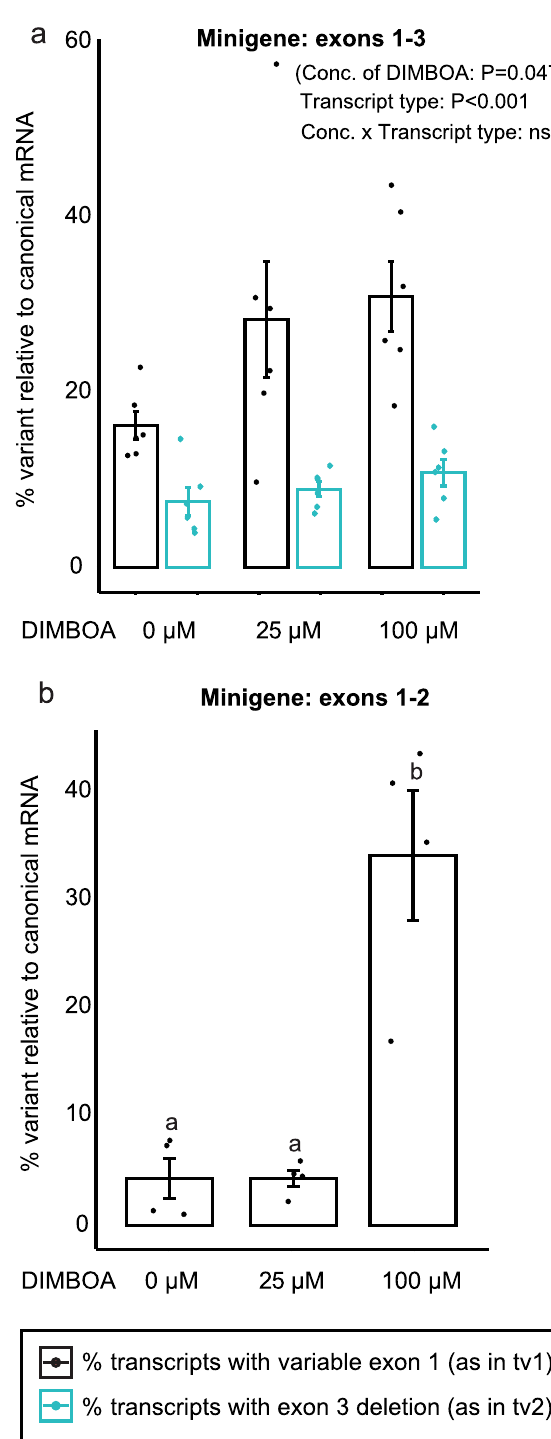
Figure 3. Splicing of SfUGT33F28 -derived minigenes in Trichoplusia ni -derived Hi5 insect cells. ( a ) Real time PCR quantification of variable mRNA relative to the canonical SfUGT33F28 transcripts in ( a ) the minigene containing exons 1–3 and ( b ) the minigene containing exons 1–2, with and without DIMBOA treatment. Data are represented as mean ± SEM (n = 4–6). Two-way repeated measures ANOVA was performed, and the Holm–Sidak method was applied to carry out all pairwise comparisons in ( a ), while one-way repeated measures ANOVA was performed, and the Holm–Sidak method was applied to carry out all pairwise comparisons in ( b ). Small letters on the bars indicate significant differences at P <